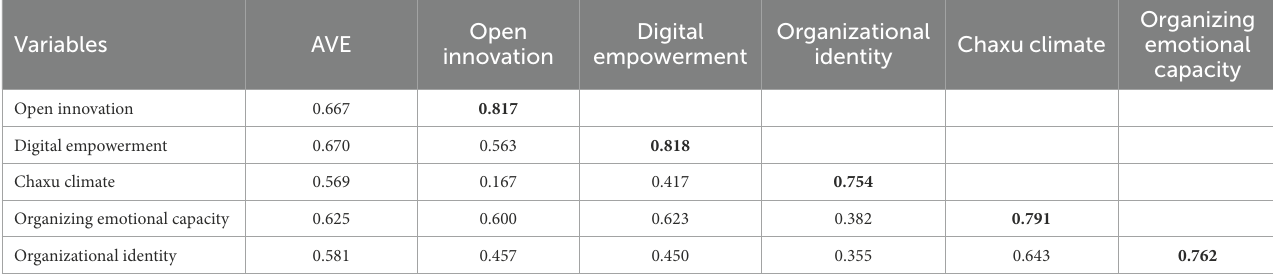
TABLE 3 Differential validity